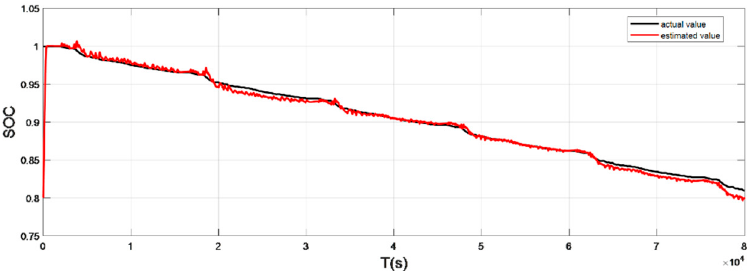
Figure 13. The SOC estimation error under constant current discharge (normal temperature: 25 °C).